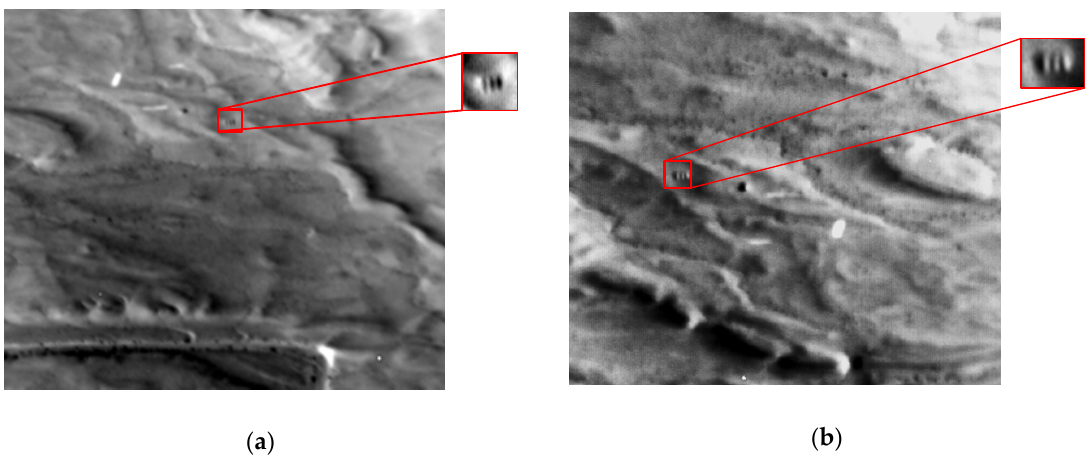
Figure 10. Photographed images of the two fixed-point modes ( a ) image obtained from the first fixed-point imaging; ( b ) image obtained from the second fixed-point imaging.